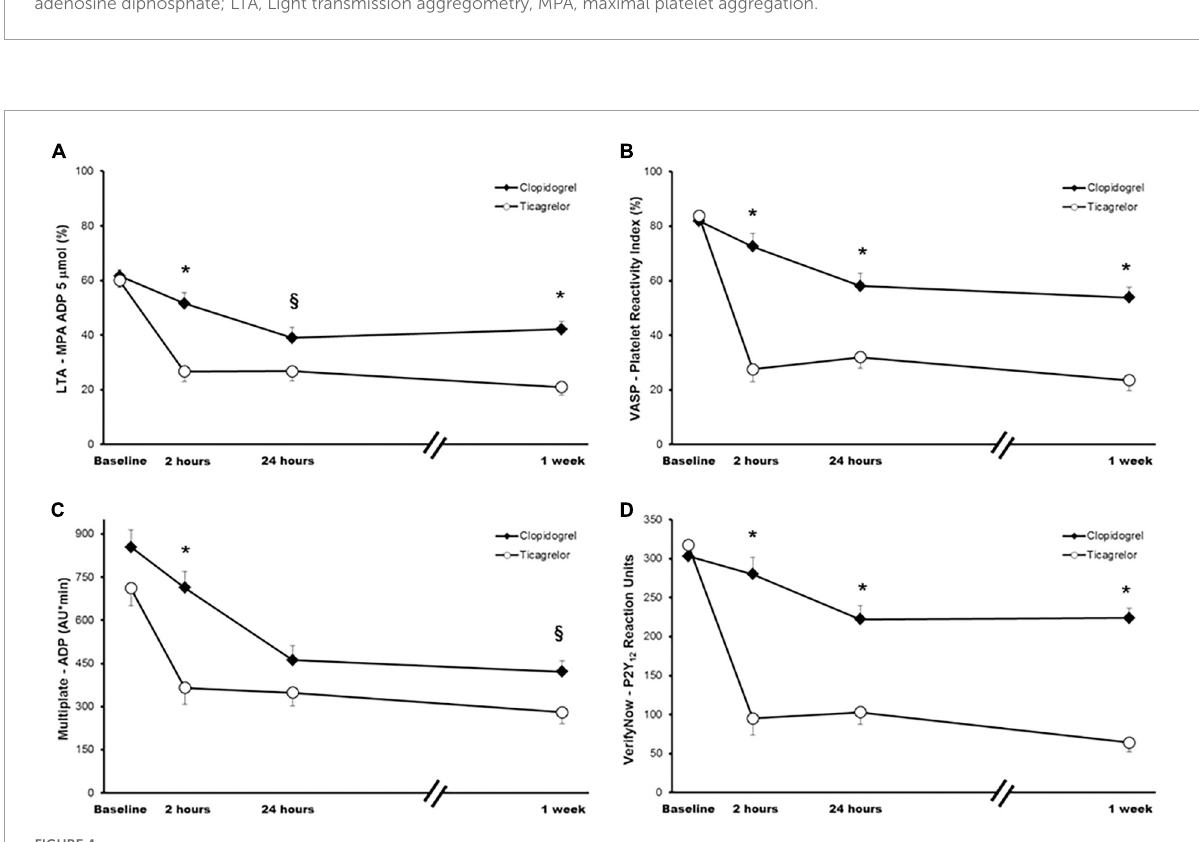
FIGURE4 Platelet function measurements across study time points. (A) Light transmittance aggregometry using 5 µ M adenosine diphosphate (ADP) as agonist. (B) Flow cytometric VASP analysis. (C) Multiple electrode aggregometry using ADP as agonist. (D) VerifyNow P2Y 12 assay. Values are expressed as least-squares means. Error bars indicate standard errors of the mean. * p < 0.001; § p < 0.05. LTA, light transmission aggregometry; MPA, maximal platelet aggregation; VASP, vasodilator-stimulated